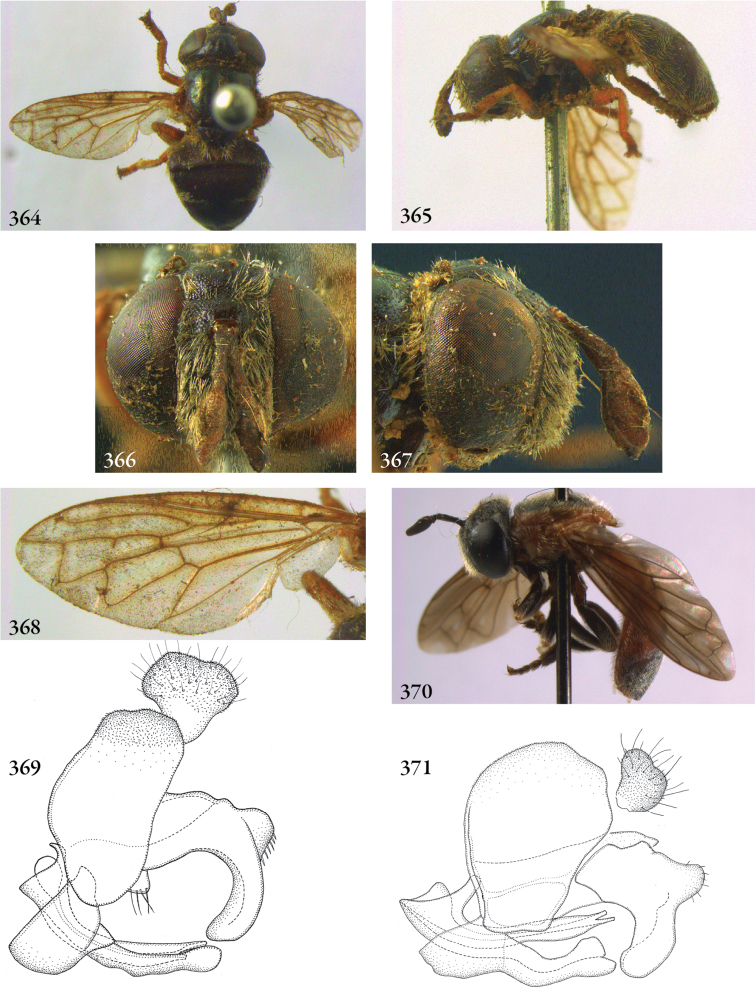
364–369
Serichlamys rufipes male (holotype): 364 habitus dorsal 365 habitus lateral 366 head frontal 367 head lateral 368 wing 369 genitalia lateral 370–371
Serichlamys scutifer (USA, Texas, coll. RMNH): 370 habitus lateral 371 genitalia lateral.